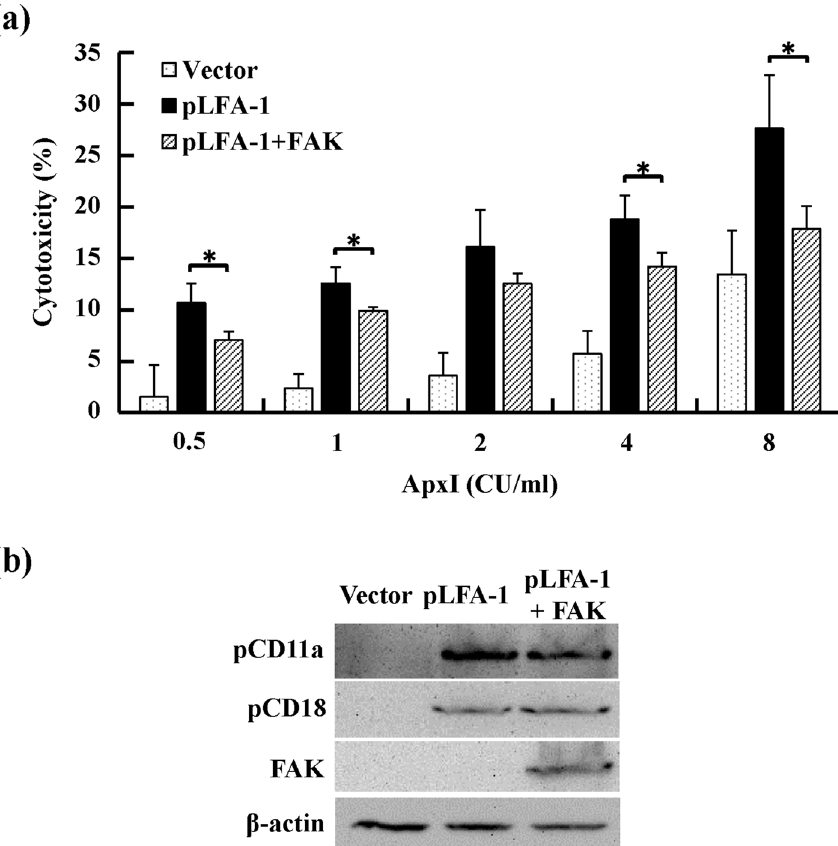
Figure 7. Ectopic expression of FAK attenuates ApxI-induced cytotoxicity in pLFA-1-transfected FAK- deficient MEFs. ( a ) FAK-deficient MEFs were transfected with plasmids expressing porcine LFA-1 (pLFA-1), in combination with a plasmid encoding FAK (pLFA-1 + FAK) or the corresponding empty vectors (Vector) for 24 h. The transfected cells were incubated with ApxI for 5 h. The culture supernatants were collected and analyzed using the LDH release assay. Data are from three independent experiments of triplicate determinants. * p < 0.05. ( b ) FAK-deficient MEFs were transfected with plasmids expressing porcine LFA-1 (pLFA-1) alone, in combination with a plasmid encoding FAK (pLFA-1 + FAK), or the corresponding empty vectors (Vector). Levels of pCD11a, pCD18, and p-FAK Y397 were examined using Western blot analyses. Immunoblots were also probed with an anti-β-actin antibody as the loading control. The grouping of blots was cropped from different portions of the same gel and exposed separately. Uncropped blot images for ( b ) are presented in Supplementary Figure